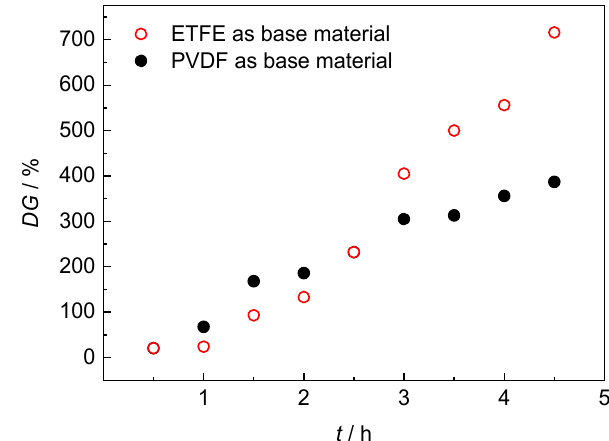
Figure 2. Impact of reaction time on DG for copolymeriaztions with f AMPS = 0.5 and V m = 0.2 at 80 °C. PVDF and ETFE were treated with 100 kGy.